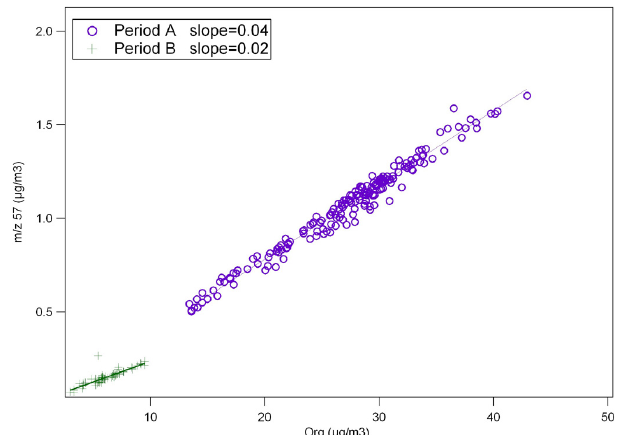
Fig. 7. f 44 vs. f 43 for Periods A and B and the transformation period between them. The area enclosed by the red triangular is adopted from Ng et al. (2010) and represents the common values of ambient OOA components from different sites including ground and flight data, HULIS (humic-like substances) and fulvic acid sam- ples.